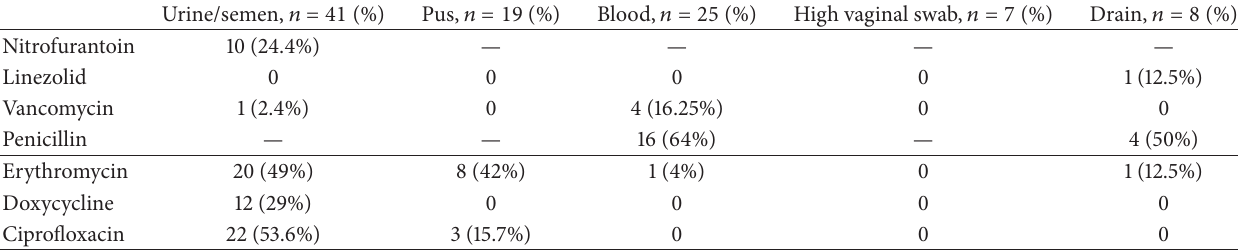
Table 1: Antibiotic resistance pattern of Enterococcus spp. in clinical specimen by disc diffusion test.